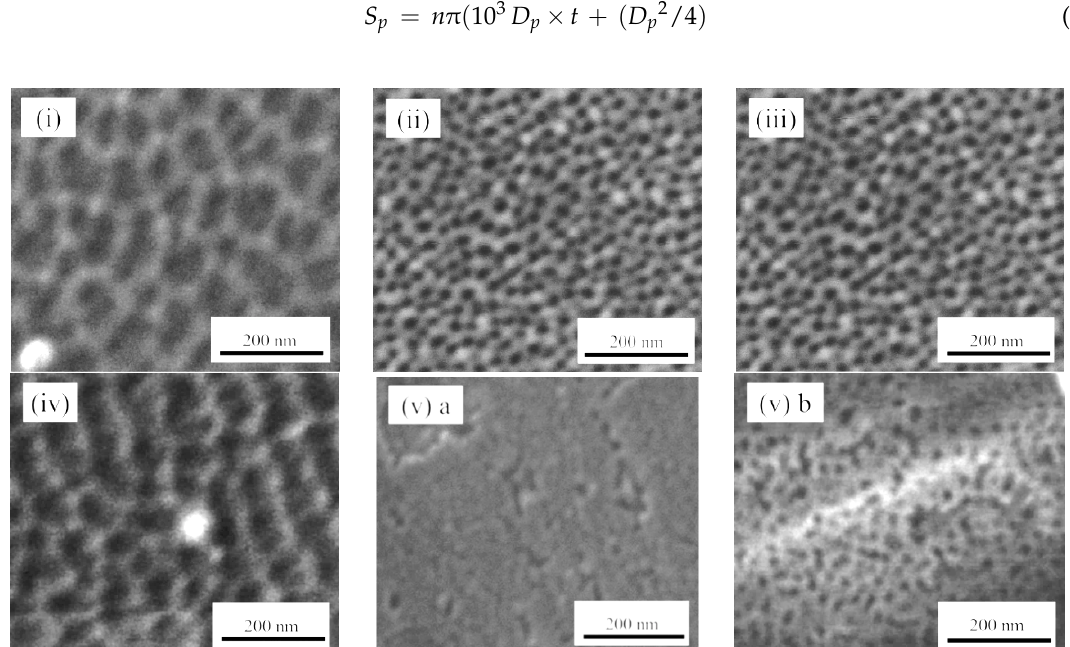
Figure 2. SEM images of the APA surfaces prepared in sulfuric acid under the anodizing conditions listed in Table 1. Electropolishing pretreatment of the Al surface: ( i ) one-step, 20 V in 0.3 M; ( ii ) two-step, 20 V in 0.3 M; ( iii ) two-step, 10 V in 0.3 M; ( iv ) one-step, 3 A/dm 2 in 1.5 M. Degreasing pretreatment of the Al surface: ( (v)a ) one-step, 3 A/dm 2 in 1.5 M as-prepared and ( (v)b ) subsequently electropolished APA surfaces. Table 1. Anodizing conditions utilized for preparation of APA surfaces in sulfuric acid either at a constant potential (potentiostatic method) or constant current (galvanostatic method) method via one-step or two-step anodization. The Al surfaces were pretreated by either electropolishing (EP) or alkaline degreasing (AD).